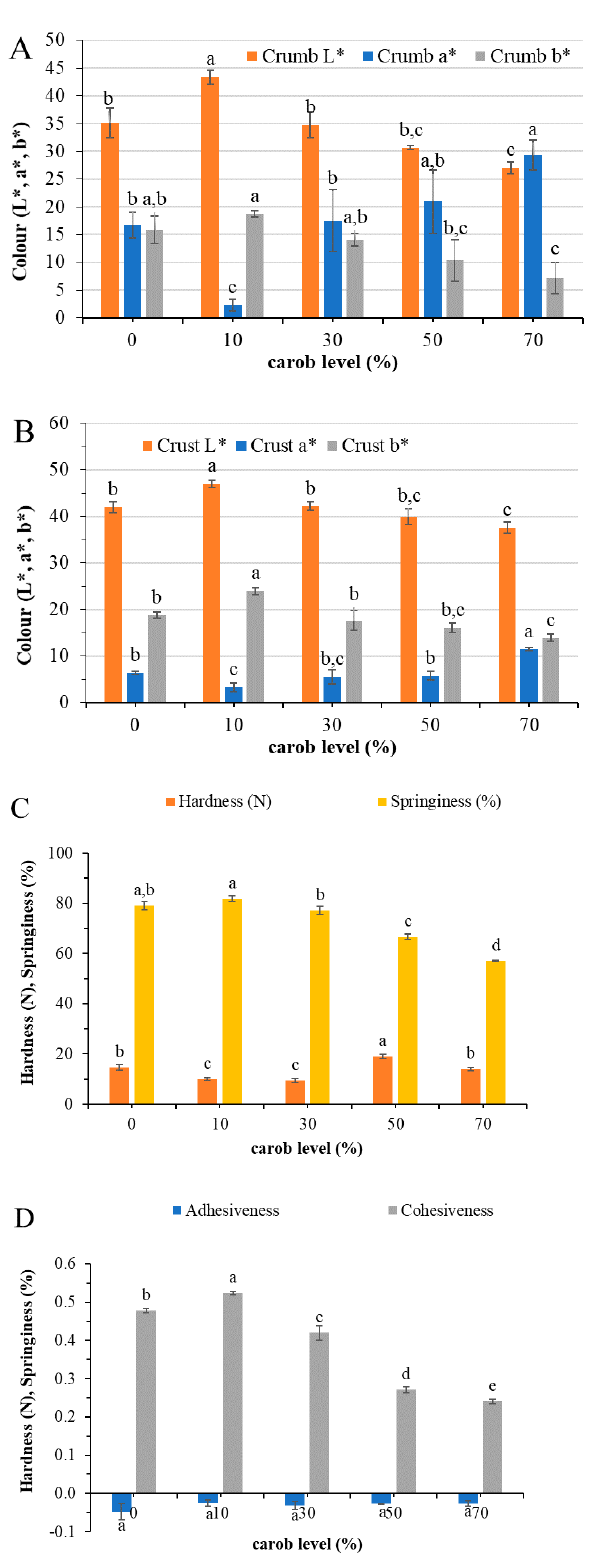
Figure 1. Crumb ( A ) and crust ( B ) color, as well as texture parameters ( C , D ) of control cake ((0% carob, 15% cocoa (f.b.)) and carob cakes prepared with di ff erent levels of carob flour. Data represent means ± SD ( n = 3). Means that do not share a letter are significantly di ff erent ( p < 0.05) according to Tukey’s pairwise comparison of